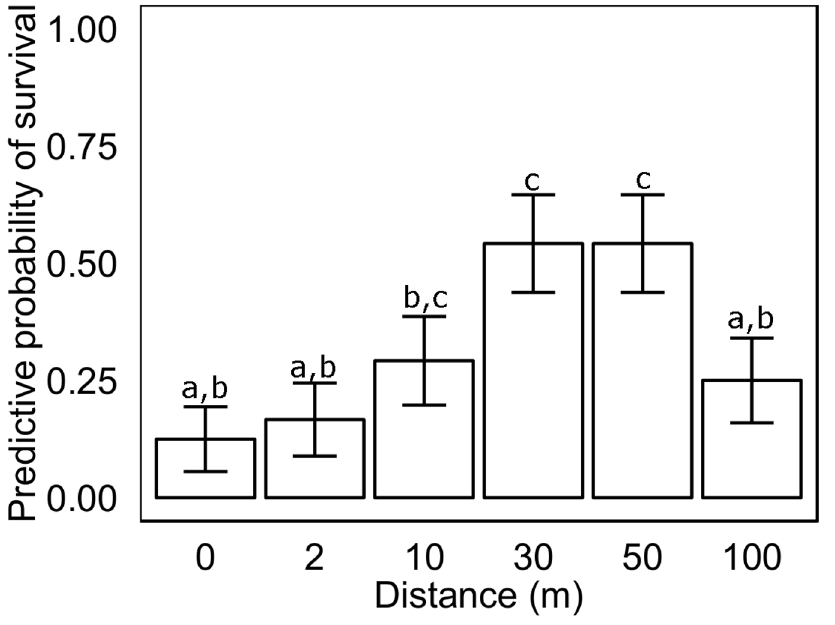
Fig 4. Predictive probability of survival of Posidonia australis transplants six months after planting (November 2012) at increasing distances from a P . australis meadow edge. Columns represent means ± 1 SE (n =